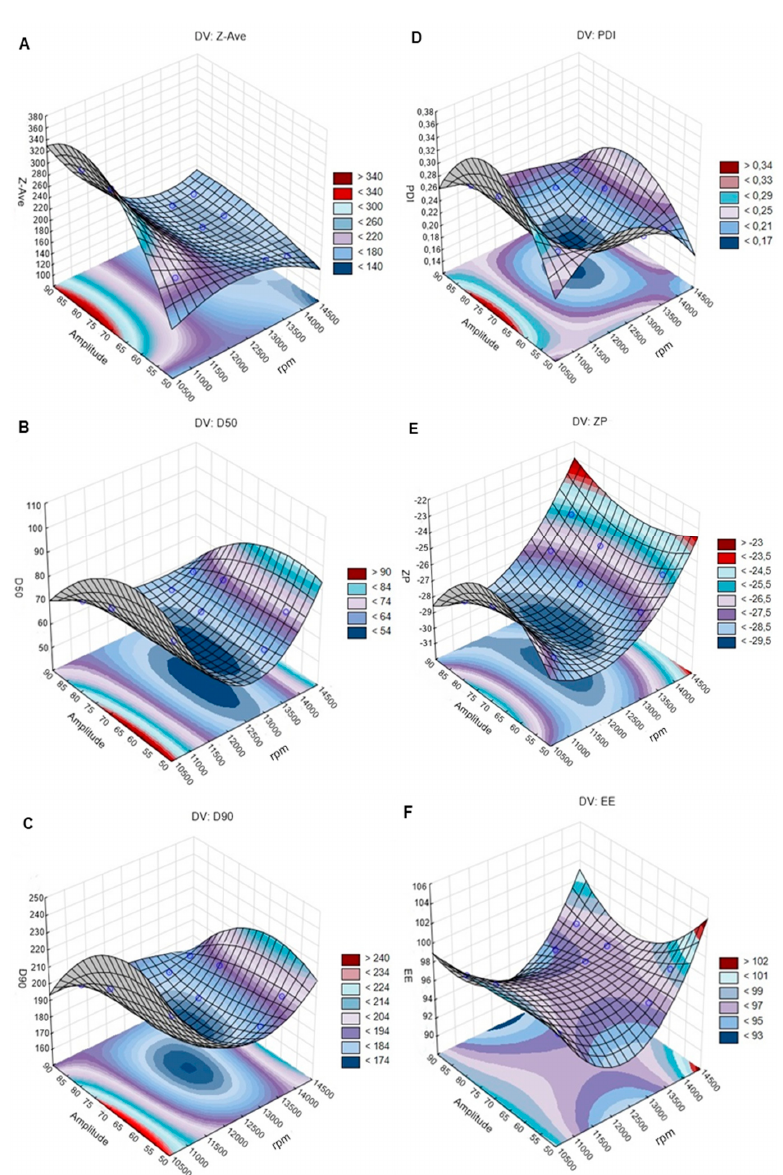
Figure 3. The 3-D surface plots portraying the effect of the sonication amplitude and emulsification speed (rpm) on the size (Z-Ave (mean particle size); D50 (50% of particles size equal or lower to the given value) and D90 (90% of particles with size equal or lower to the given value)) (left: A – C ), polydispersity index (PDI), zeta potential (ZP), and encapsulation efficiency (EE) (right: D – F ).